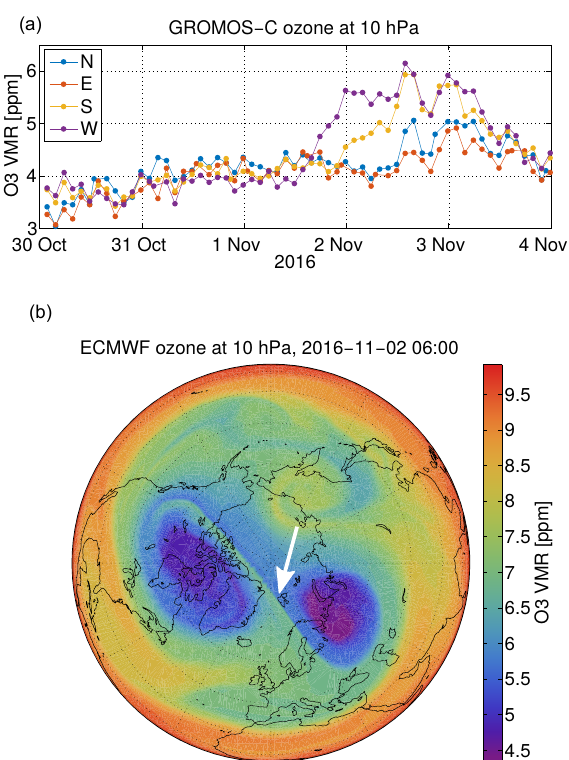
Figure 2. GROMOS-C ozone measurements in the four cardinal di- rections (N–E–S–W) at 10hPa in November 2016 (a) and ECMWF data at 10hPa (b) . The arrow points to the location of Ny-Ålesund.